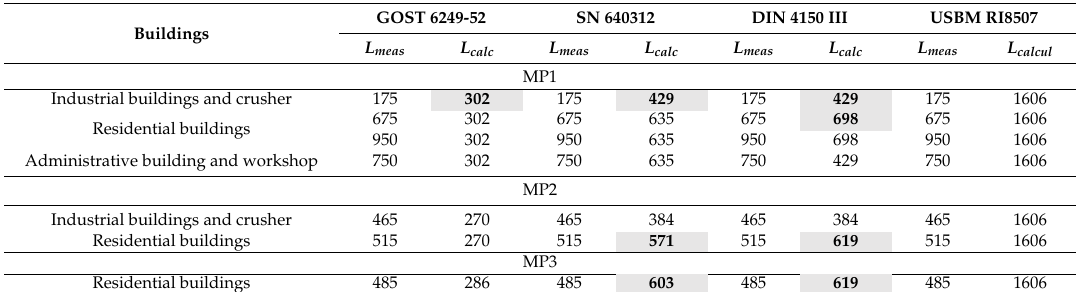
Table 3. Summary of the calculation results for safety distances related to the designed and used explosive quantities [7].